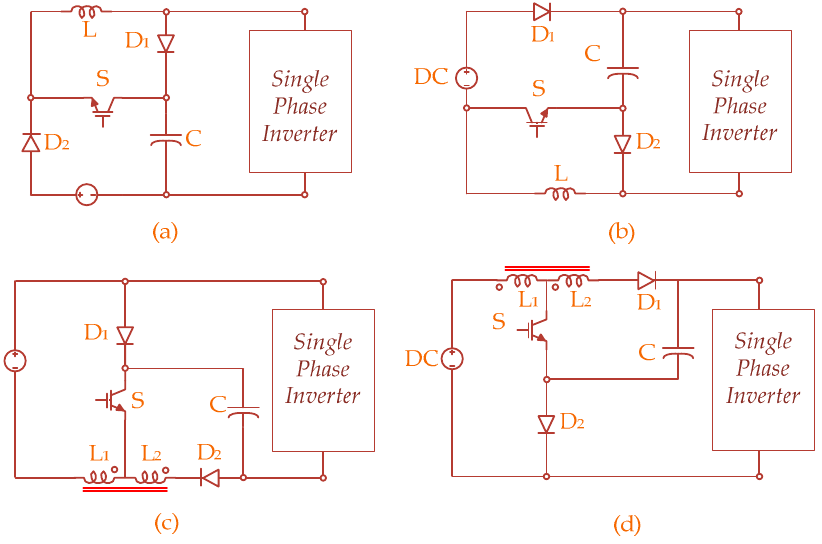
Figure 1. ( a ) Switched boost inverter (SBI) topologies Type 1; ( b ) Switched boost inverter (SBI) topologies Type 2; ( c ) Trans switched-boost inverter Topologies Type 1; ( d ) Trans switched-boost inverter topologies Type 2.